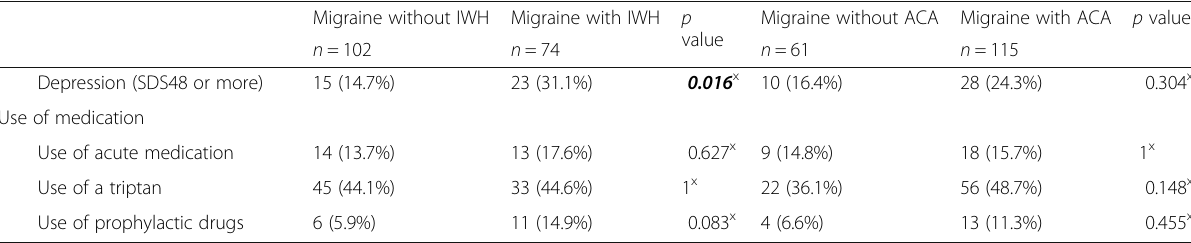
Table 3 Baseline characteristics of 176 migraine patient, separated by the presence of interictal widespread hyperalgesia (left) and acute allodynia (right) (Continued) Migraine without IWH Migraine with IWH p value